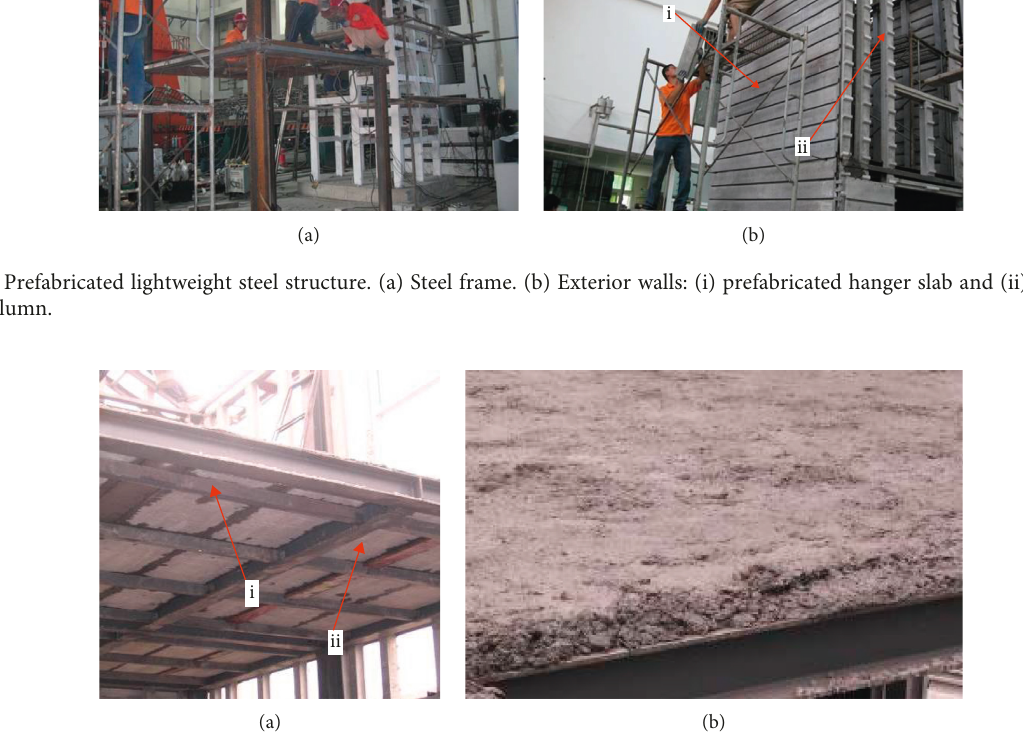
Figure 2: Sketch of floorslab. (a) Floorslab: (i) hot-rolled equilateral angle steel and (ii) reinforced concrete superposed slab. (b) Fine aggregate concrete.